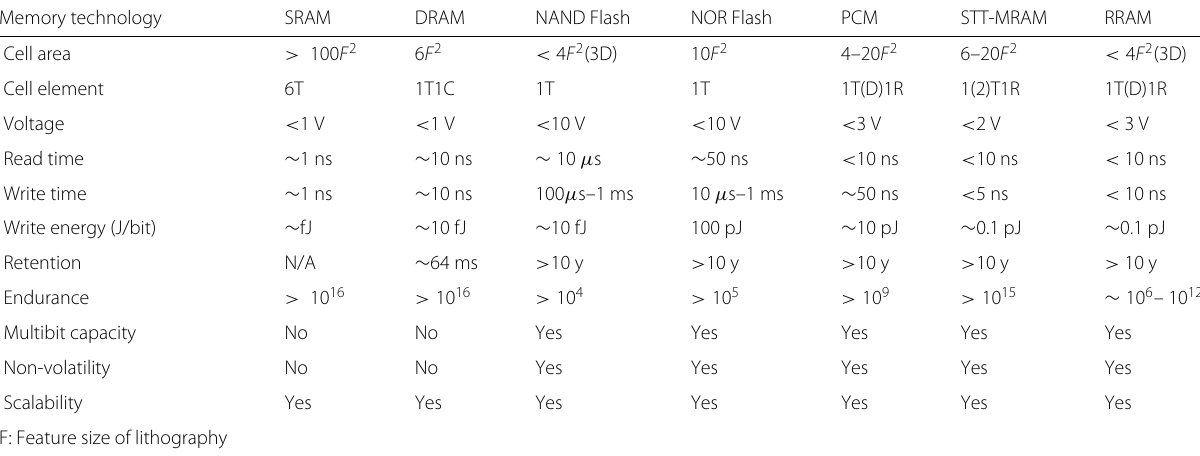
Table 1 Comparison of emerging memory technologies Memory technology